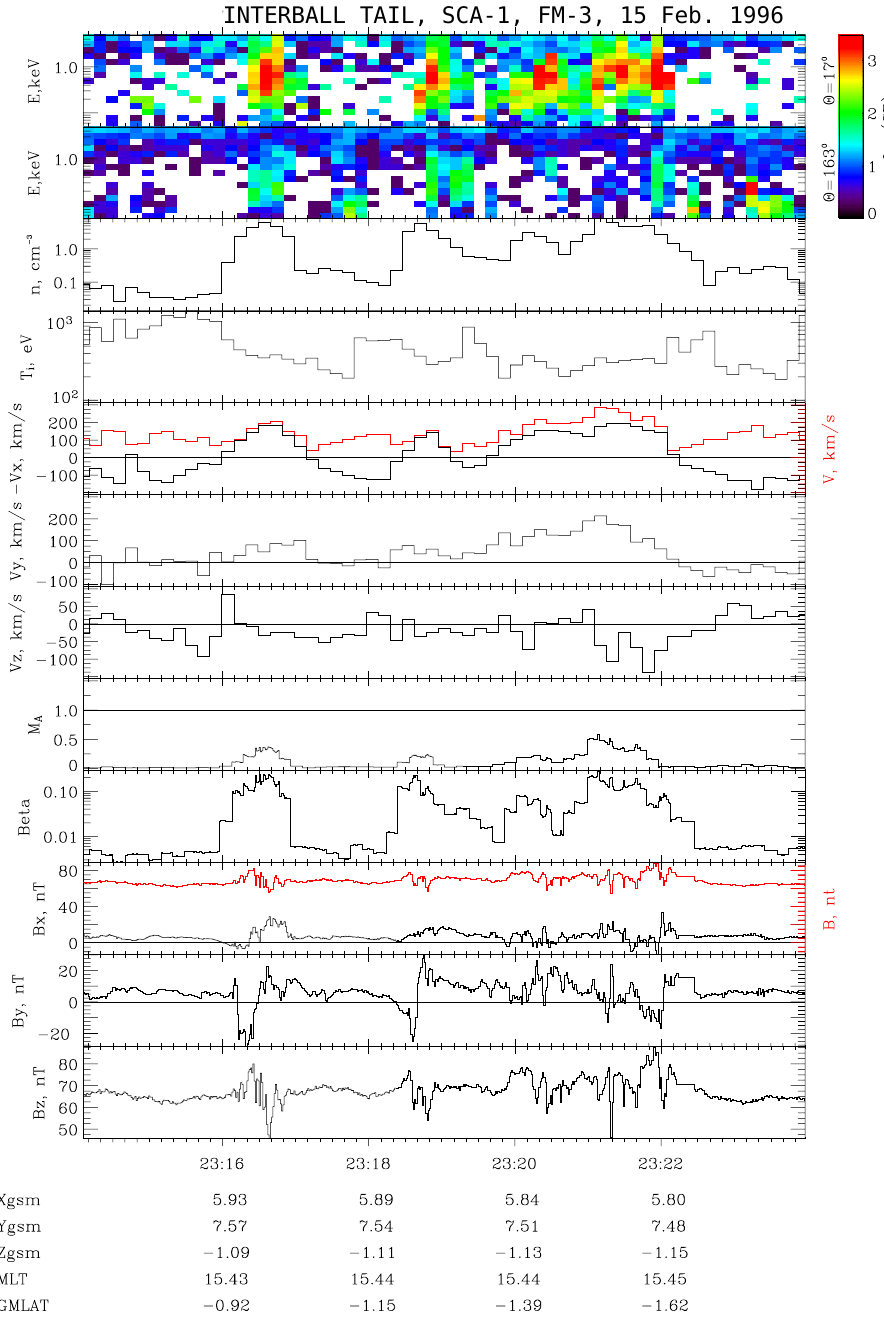
Fig. 14. Transients observed on inbound trajectory of Interball on 16 April 1996. Format is the same as in Fig. 2.